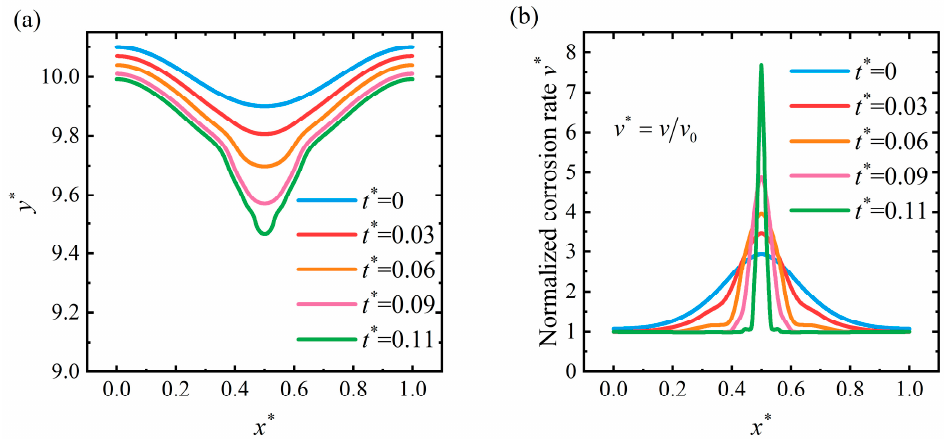
Figure 8. ( a ) Surface morphology evolution process and ( b ) corrosion rate distribution when A ∗ = 0.1 and σ A = 100 MPa.